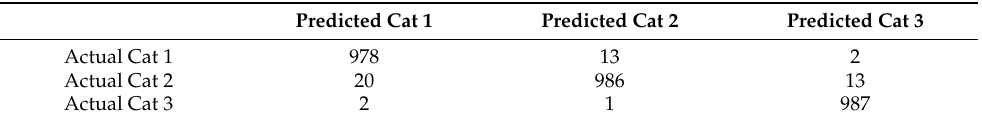
Table 5. Results of triaged referrals vs. actual dataset.